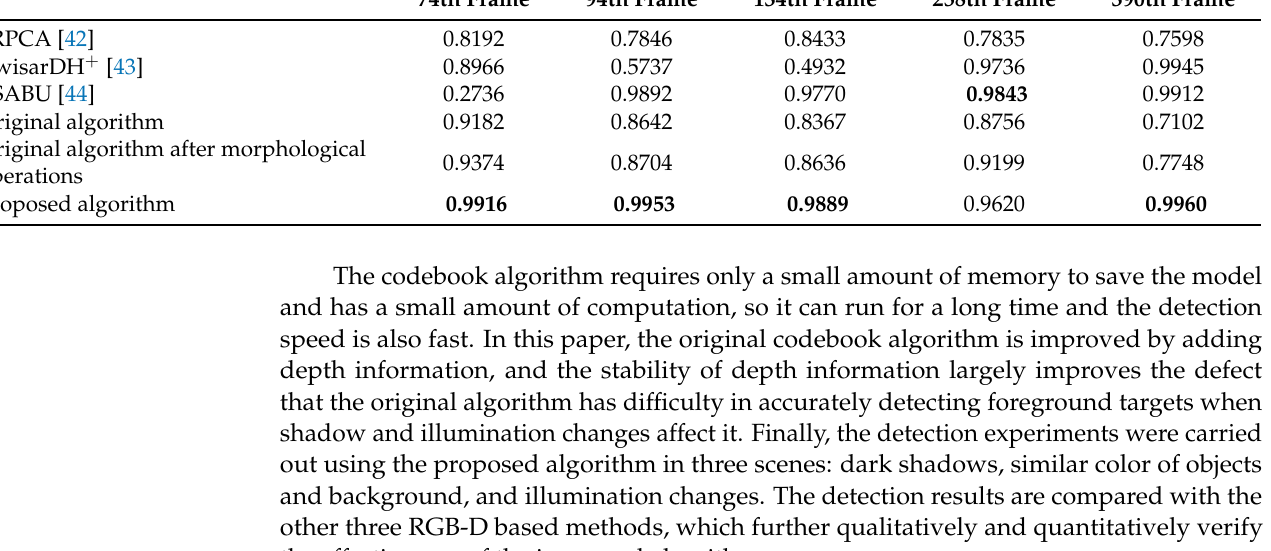
Table 4. Comparison of the F-values of the proposed method with several RGB-D based methods in recent years for 3 scenarios. The results with the best performance in each scenario have been bolded. Wall Hallway Shelves 74th Frame 94th Frame 134th Frame 258th Frame 390th